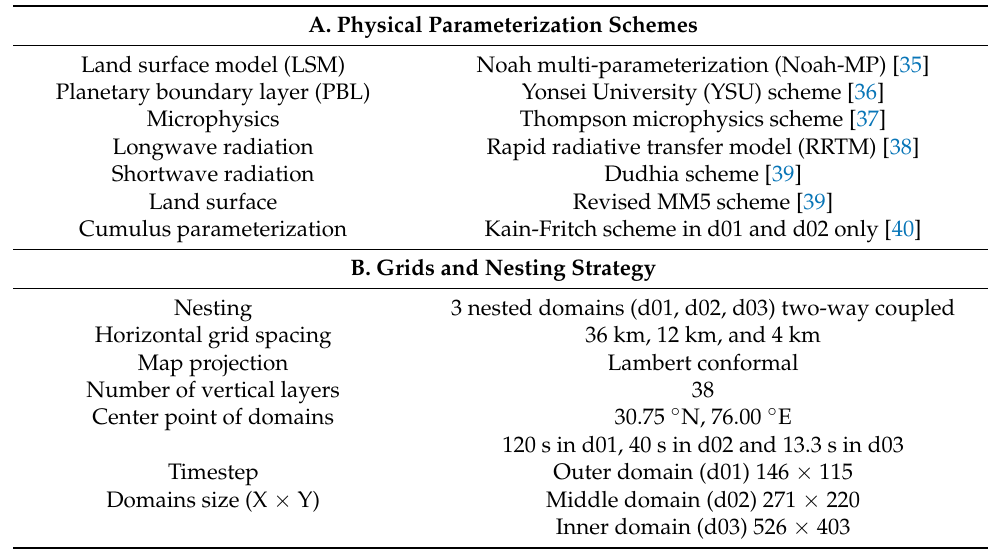
Figure 1. WRF domains (red, blue, and black boxes), Karakoram and western Himalaya subregions used for detailed analysis (green boxes), transects (black dashed lines), and 9 arc-second relief of HMA (m, shaded following inset scale). Table 1. Model